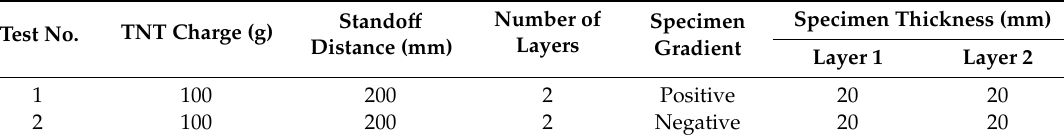
Figure 3. Sketch of the experimental setup. Table 2. Details of specimens and blast loads.